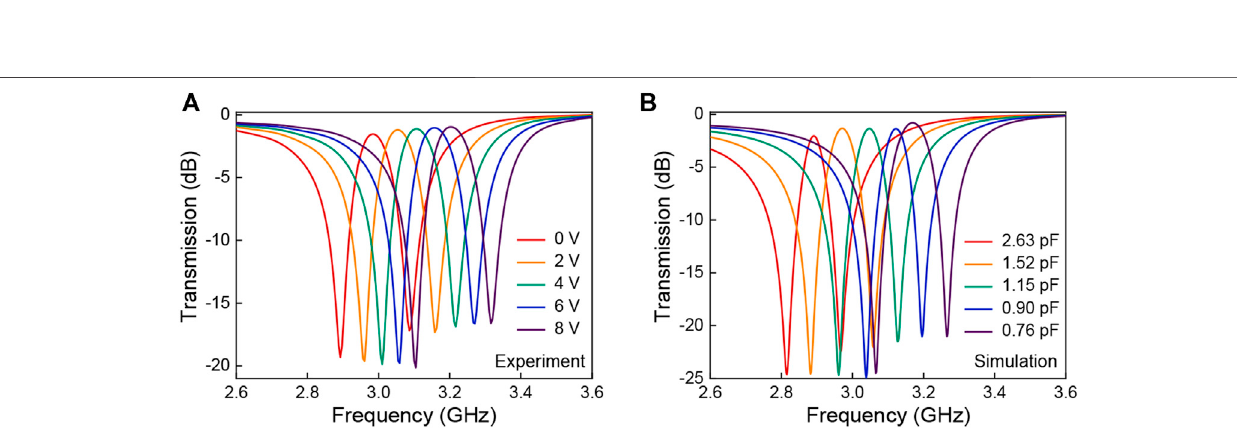
Frontiers in Physics |